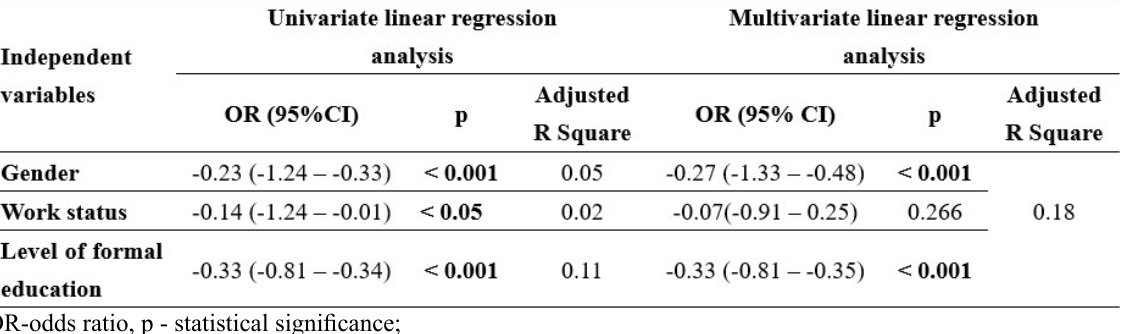
Table 5. Prediction of non-formal education